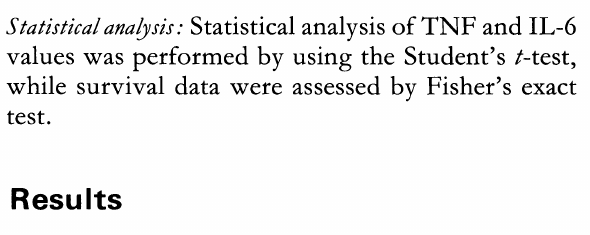
FIG.2. Variations in body temperature (squares) and body weight (circles) in control (open symbols) and LPS-challenged mice (closed symbols). Animals were checked up to I0 days after LPS administration at day 0 (30 mg/kg,